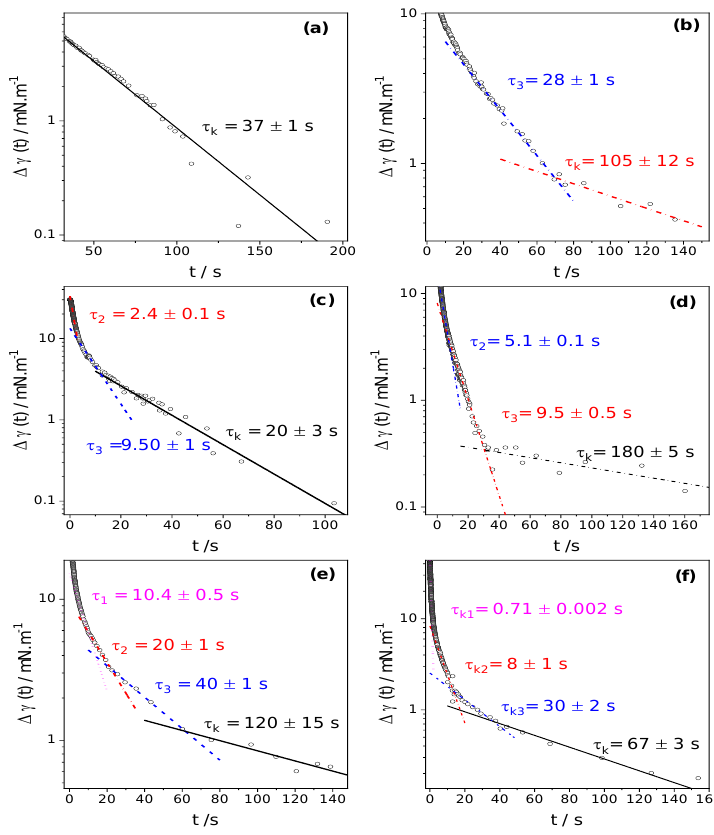
Figure 9. Several relaxation processes following an exponential decay were observed in dynamic surface tension curves at concentrations below the cmc. ( a ) c s = 0.1 mM, ( b ) 0.2 mM, ( c ) 0.3 mM, ( d ) 0.4 mM, ( e ) 0.5 mM, ( f ) 0.6 mM.